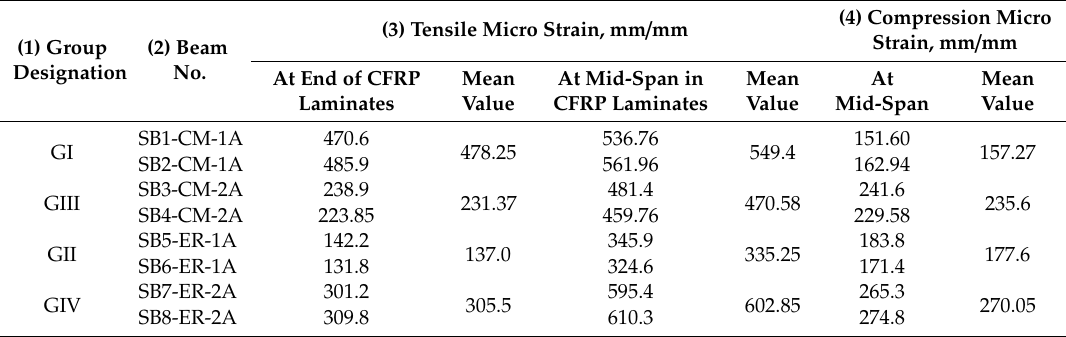
Table 7. Strains developed in segmental